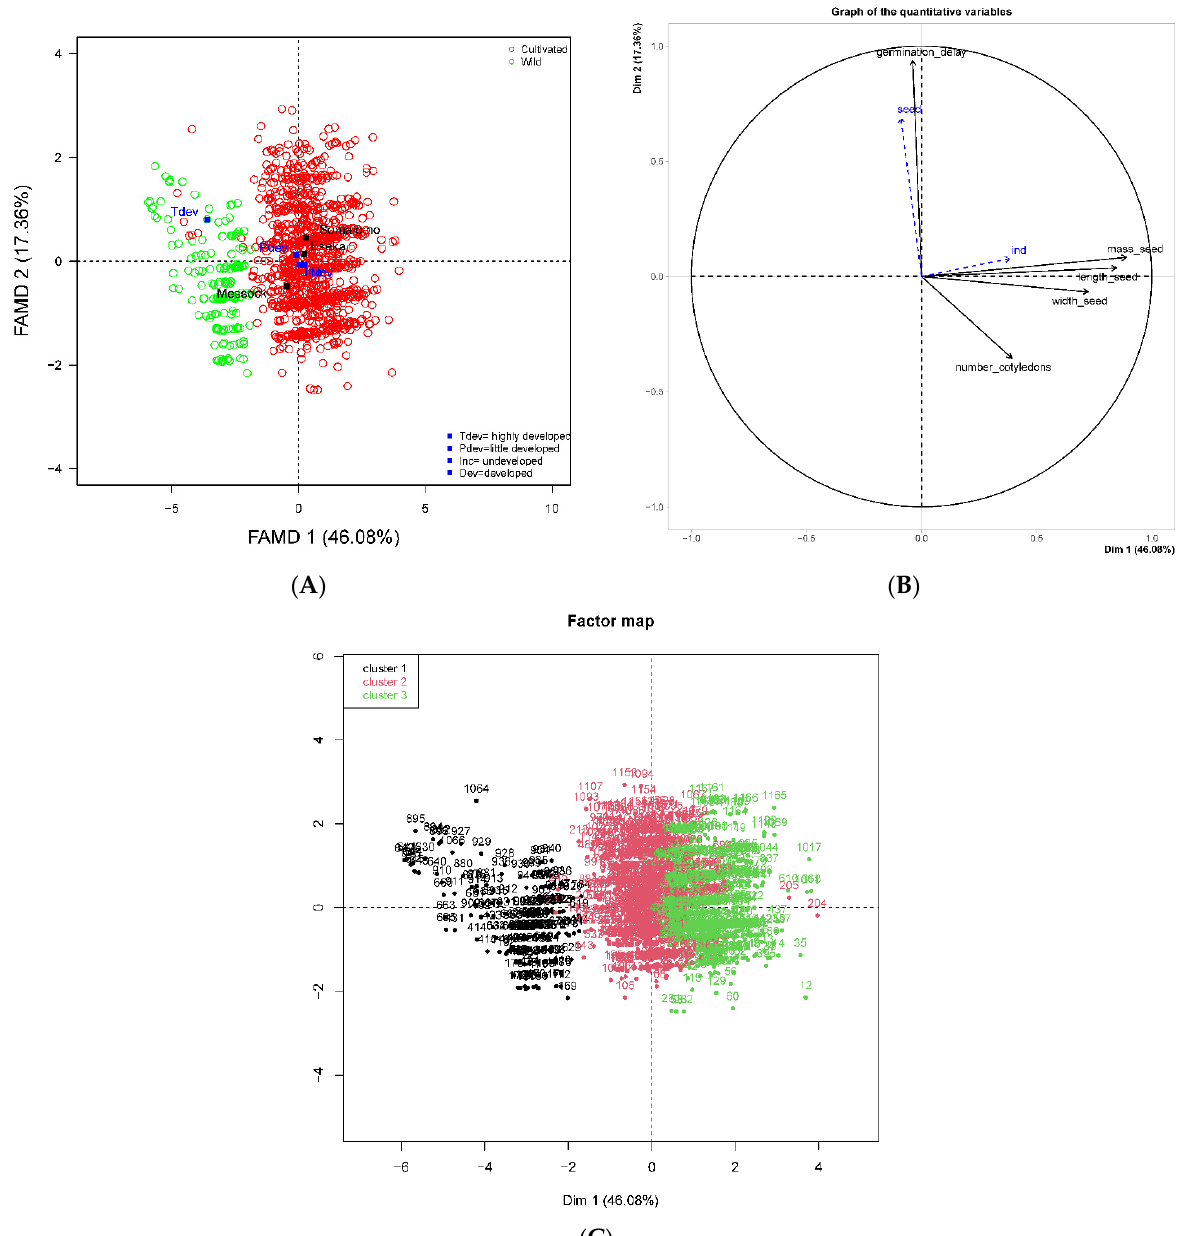
Figure 5. Classification of wild and cultivated seeds by FAMD analyses. ( A ) Discrimination of wild and cultivated seeds from the FAMD according to axes 1 and 2. ( B ) Correlation and contribution of variables to the formation of axes 1 and 2. ( C ) Clustering of seeds based on the wild and cultivated status of their mother’